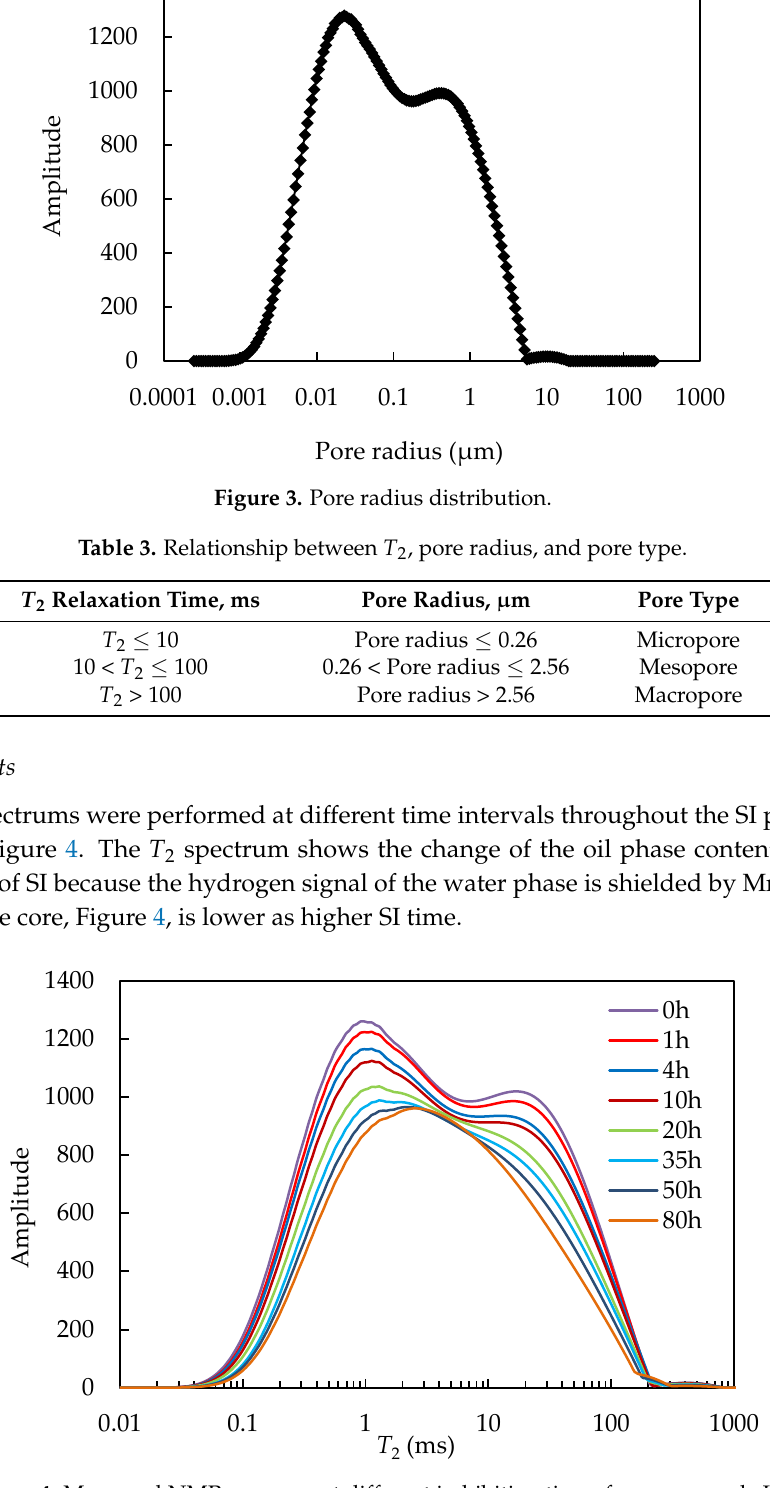
Figure 4. Measured NMR response at different imbibition times for core sample I01.